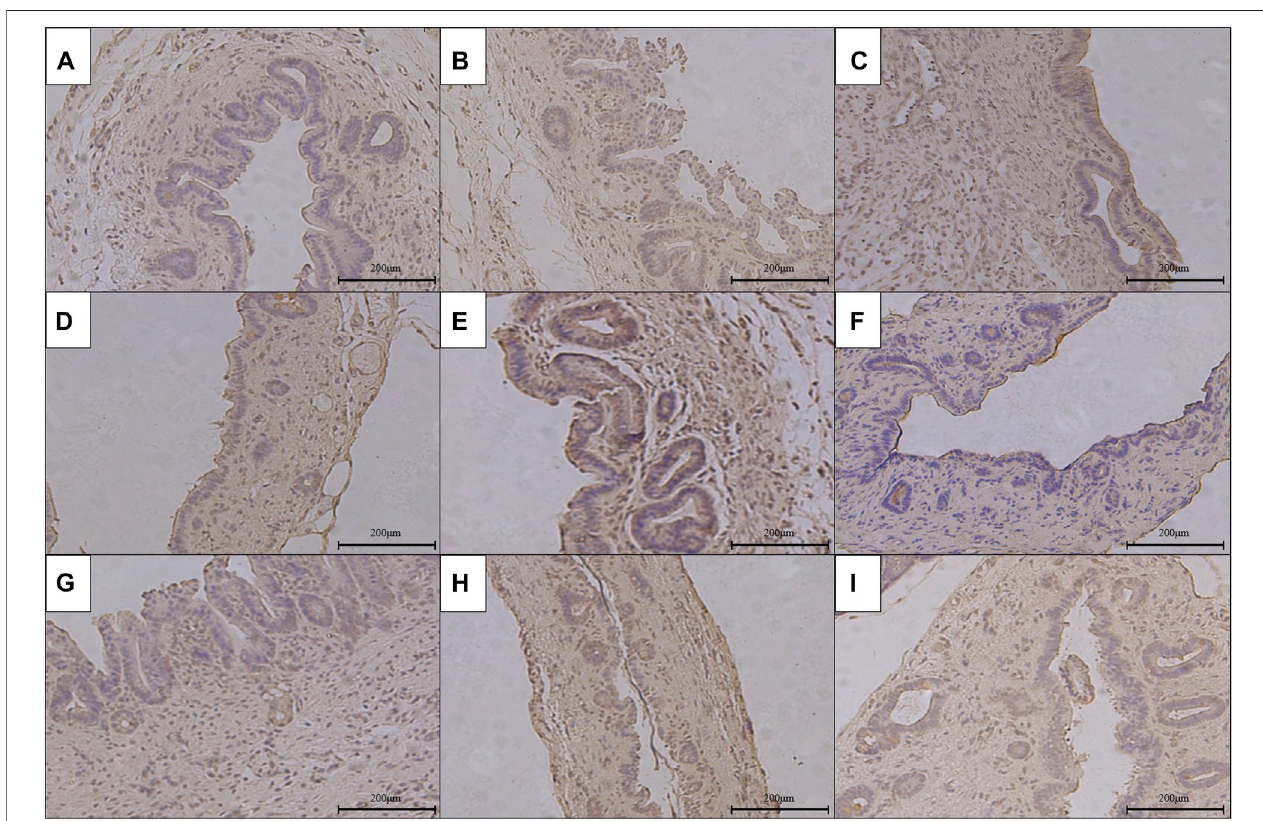
FIGURE 7 | Immunohistochemical staining of TGF- β 1 in the anastomotic stoma after RCJS in different groups ( × 200). (A) IHC staining of TGF- β 1 in the sham operationgroup. (B) IHCstainingofTGF- β 1inthecontrolgroupat1 weekaftertheRCJSprocedure. (C) IHCstainingofTGF- β 1inthecontrolgroupat1 monthafterthe RCJS procedure. (D) IHC staining of TGF- β 1 in the anisodamine intervention group at 1 week after the RCJS procedure. (E) IHC staining of TGF- β 1 in the anisodamine interventiongroupat 1 month after theRCJS procedure. (F) IHC stainingofTGF- β 1intheneostigmineintervention groupat 1 week afterthe RCJSprocedure. (G) IHC staining ofTGF- β 1 in the neostigmine intervention group at 1 month after the RCJS procedure. (H) IHC staining of TGF- β 1 in the combination group at 1 week after the RCJS procedure. (I) IHC staining of TGF- β 1 in the combination group at 1 month after the RCJS procedure.